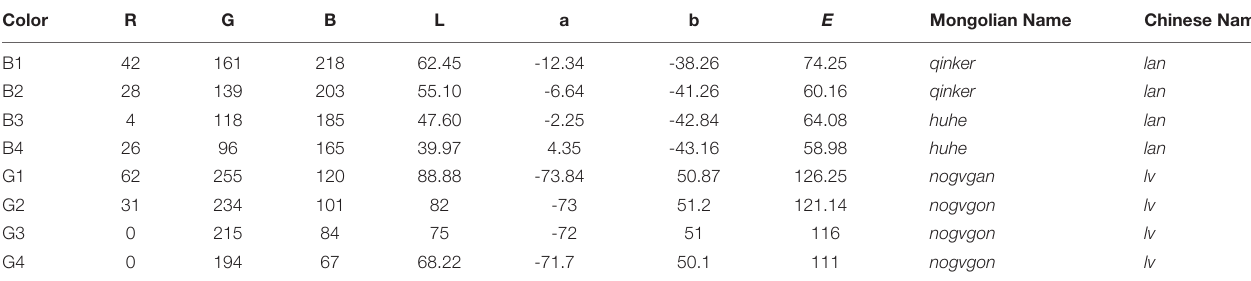
TABLE A2 | CIELAB coordinates of the stimuli of blue and green.